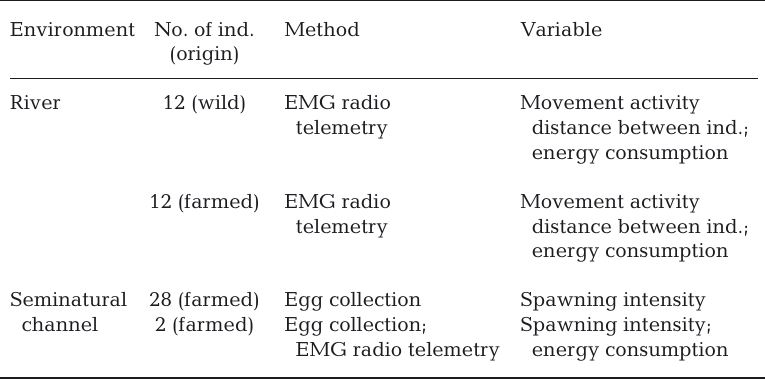
Table 2. Summary of the methods used. EMG: